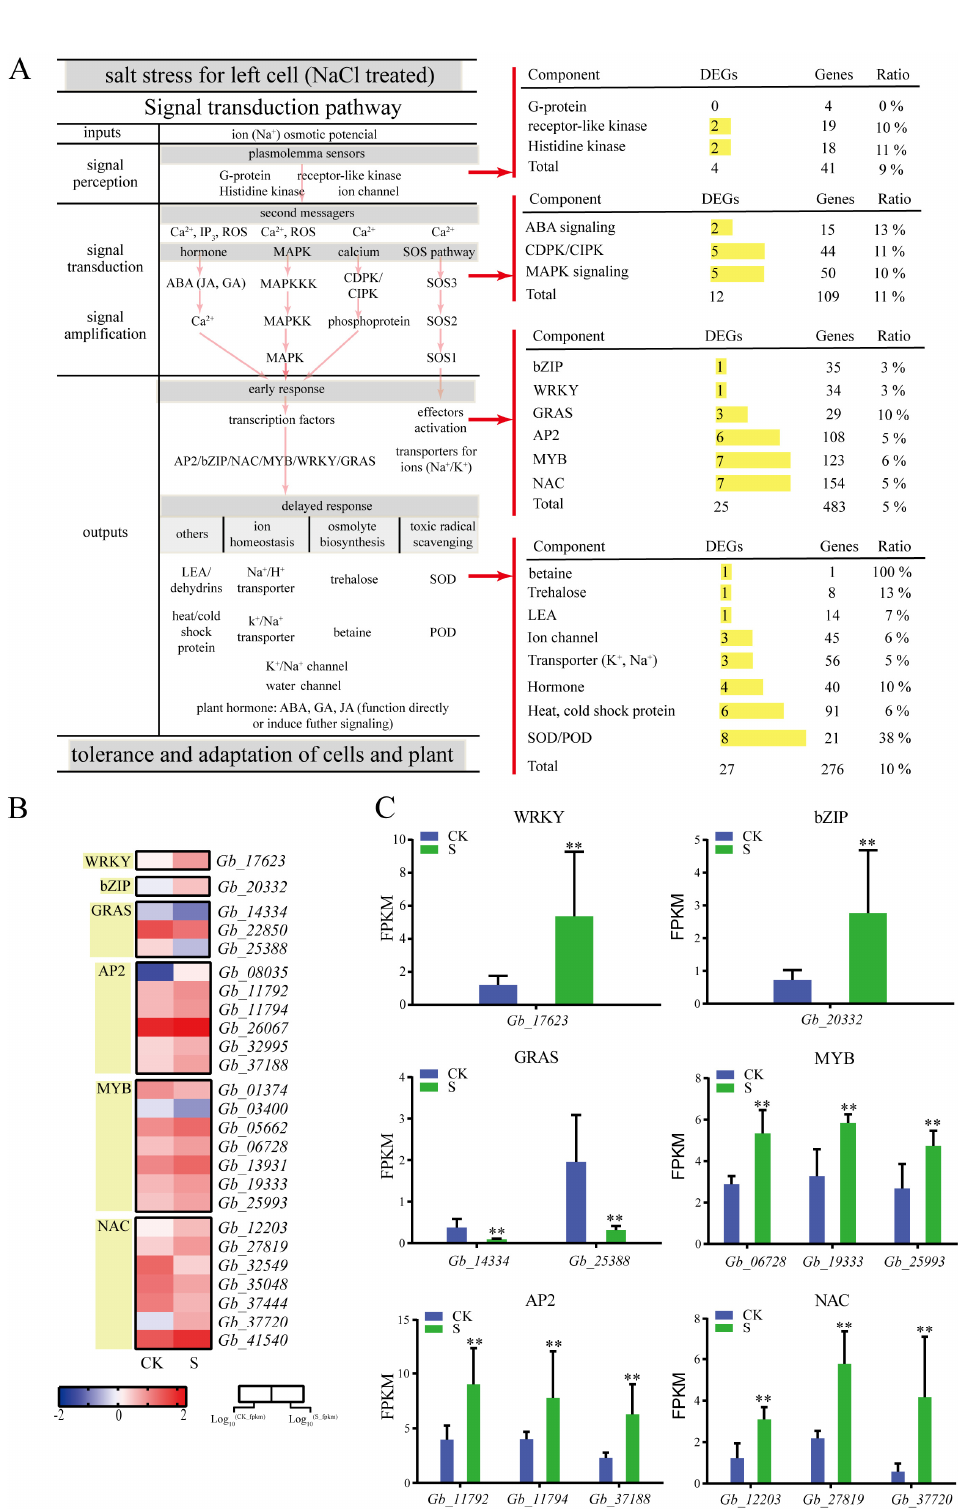
Figure 5. Expression of related genes under salt treatment. ( A ) Plant hormone, MAPK, calcium, and salt-overly-sensitive (SOS) pathways determine the framework of salt signaling. ( B ) Di ff erentially expressed transcription factors (TFs) in G. biloba leaves following NaCl treatment. The fragments per kilobase of exon model per million reads mapped (FPKM) range from low (blue) to high (red) is –2 to 2, respectively. ( C ) Transcription factor genes with significantly di ff erent FPKM values. ** p < 0.01. The vertical bars indicate SD ( n =